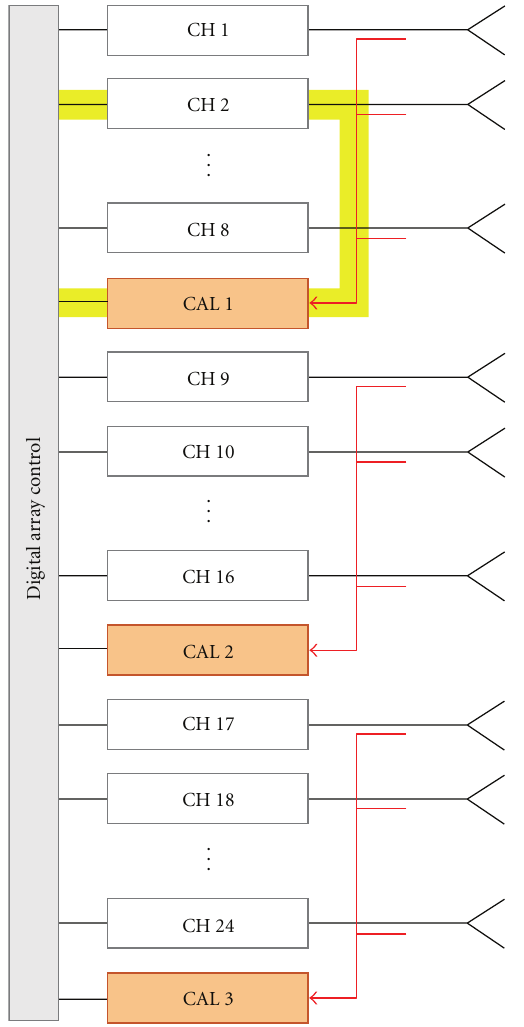
Figure 10: In the on-line calibration procedure, a signal is transmitted to a single antenna channel (e.g., CH 2) and fed back to a calibration channel by means of the calibration network to detect changes in the properties of active